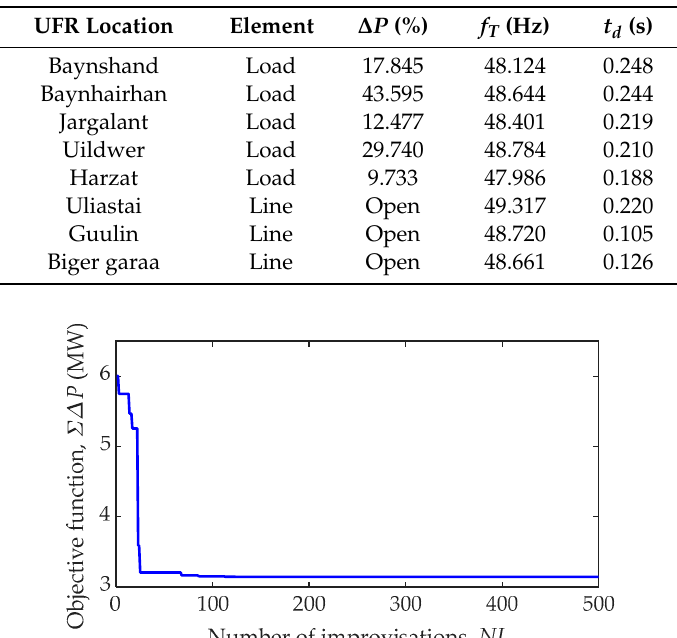
Figure 8. UFRs action in high inertia—summer season scenario: ( a ) active power; ( b ) trigger signal of the UFRs. From Figure 7, it can be observed that the traditional UFLS scheme produced an over-frequency condition that caused the frequency to reach values above 53 Hz, which could result in activation of the over-frequency protection of the synchronous generators. The frequency quality metrics were computed to verify the positive improvements of the optimal UFLS scheme in the frequency response compared with the traditional UFLS, and the results are presented in Table 4. The optimal UFLS scheme prevented an unnecessary load shedding of 1.056 MW. It improved f min by reducing the frequency depth by 0.232 Hz and avoided an over-frequency of continuing operation by settling the frequency at 49.8 Hz. The optimal setting of UFRs fulfilled the technical and operational constraints defined in (12). Table 4. Frequency quality metrics of high inertia—summer season scenario. UFLS Type